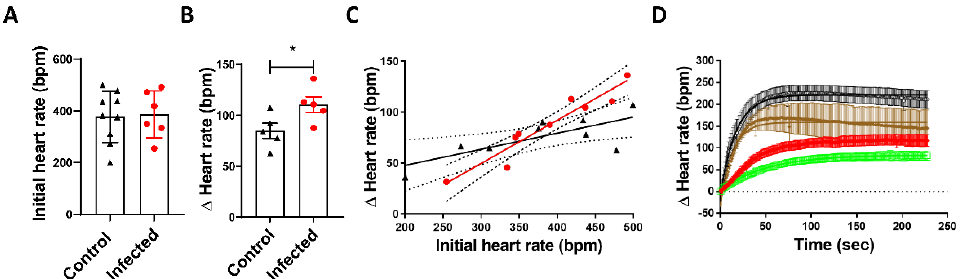
Figure 1. Heart rate kinetics in mice. ( A ) Initial heart rate in beats per min (bpm) in control (black symbols) and infected (red symbols) mice. ( B ) The Δ heart rate, defined as the differential of the heart rate at point 0 and 5 min post-ivabradine single-dose treatment, in control (black symbols) and infected (red symbols) groups. * The p -value was estimated at 0.0425 by Student’s t -test. ( C ) Linear regression between initial heart rate and the Δ heart rate in control (black symbols) and infected (red symbols) groups. Slopes were considered significantly different with a p -value of 0.0036. ( D ) Control mice were treated (brown symbols) or not treated (black symbols) with a single bolus of 5 mg/Kg of ivabradine five minutes before stimulation with 1.1 mg/Kg isoproterenol; infected mice were treated (green symbols) or not treated (red symbols) with ivabradine, like the control mice.